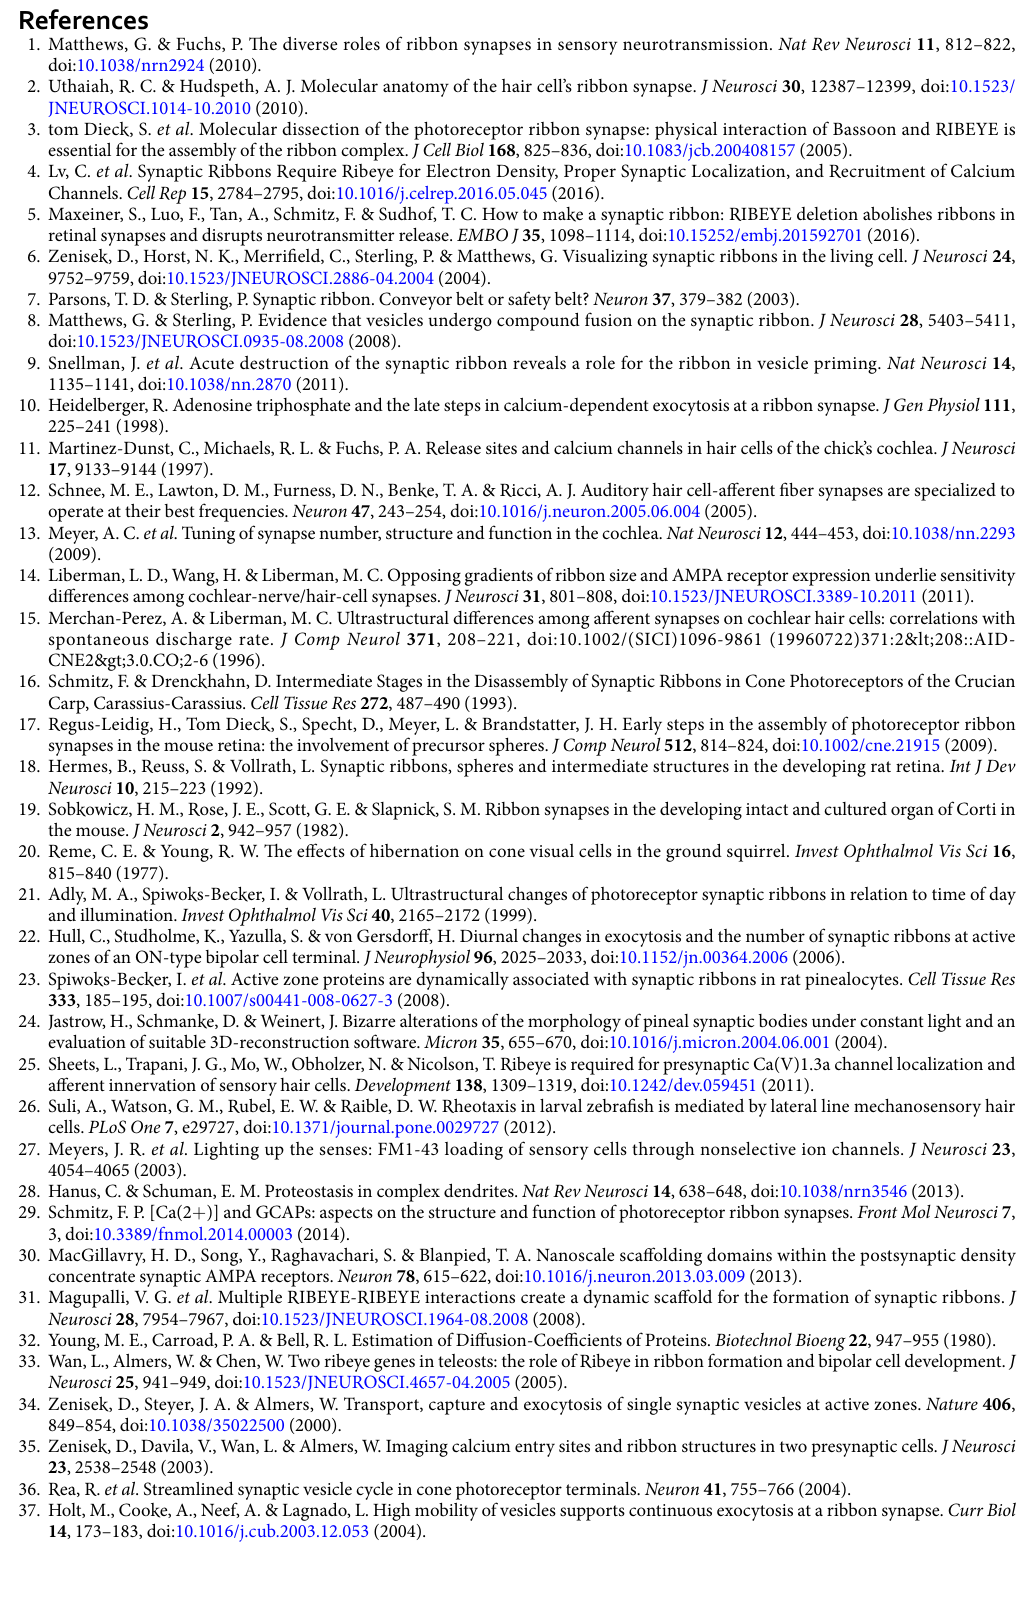
Measurement regions. For Ribeye b-EGFP FRAP measurements, measurement regions were as depicted in Fig. 2a. To measure the same relative positions on ribbons of varying size, each ribbon was divided into fifths, and the measurement region was one fifth wide by three fifths tall. Data was processed in ImageJ and IgorPro (WaveMetrics), and diffusion simulations were run in Smoldyn 2.36 (www.smoldyn.org) 49